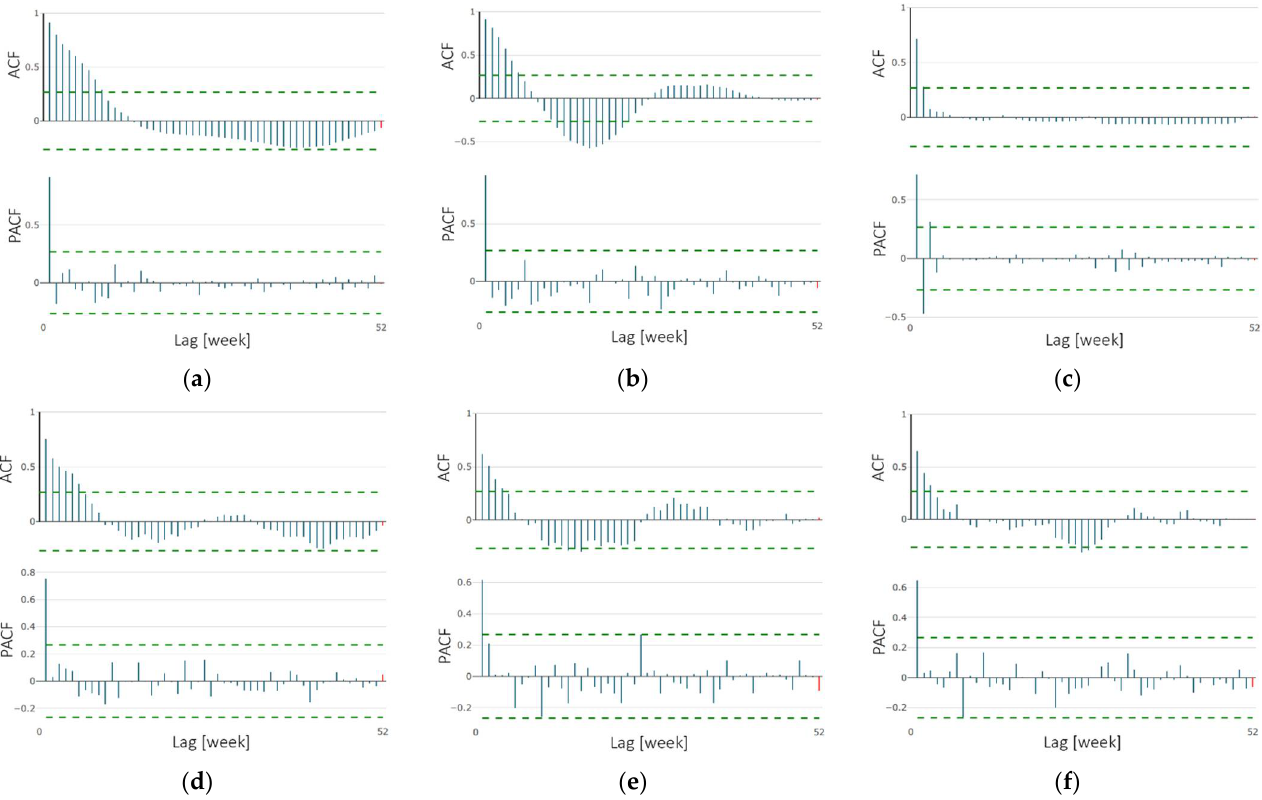
Figure 2. ACF and PACF plots of time series for ( a ) “covid”; ( b ) “flu”; ( c ) “bcg”; ( d ) “hpv”; ( e ) “pneumo”; ( f ) “polio”. The cross-correlation plots are presented in Figure 3. It can be seen that the cross- correlation of “covid”–“flu” is changeable over time, from maximum negative scores (up to 0.45 on lags interval (0.5–0.8)) to maximum positive scores (up to 0.55 on lags interval (0.15–0.5)). Currently, the growth of “covid” requests negatively correlates (negligible but close to significant level) with “flu” requests. It is also discernible that the “covid”–“bcg” cross- correlation (as shown on Figure 3b) is also changeable over time: the maximum positive values (around 0.5) appeared on interval (0.7–1), this is due to a very pronounced “bcg” cycle at the beginning of 2020, after which the cross-correlation is permanently negative (but also non-significant). This negative correlation is explained by the persistence of the “bcg” trend from 2020 without further bursting cycles and the increasing trend of “covid” requests. It can be seen that the “covid”–“hpv” cross-correlation (see Figure 3c) is also changeable over time: the maximum negative values (around − 0.6) were on interval (0.7–1), after which the cross-correlation has only positive values (predominantly significant) with maximum values near 0.4. The dynamics of interest in “covid” and “hpv” vaccines changes unidirectionally. In the “covid”–“pneumo” cross-correlation plot shown in Figure 3d it can be seen that the cross-correlation changed many times during the period under